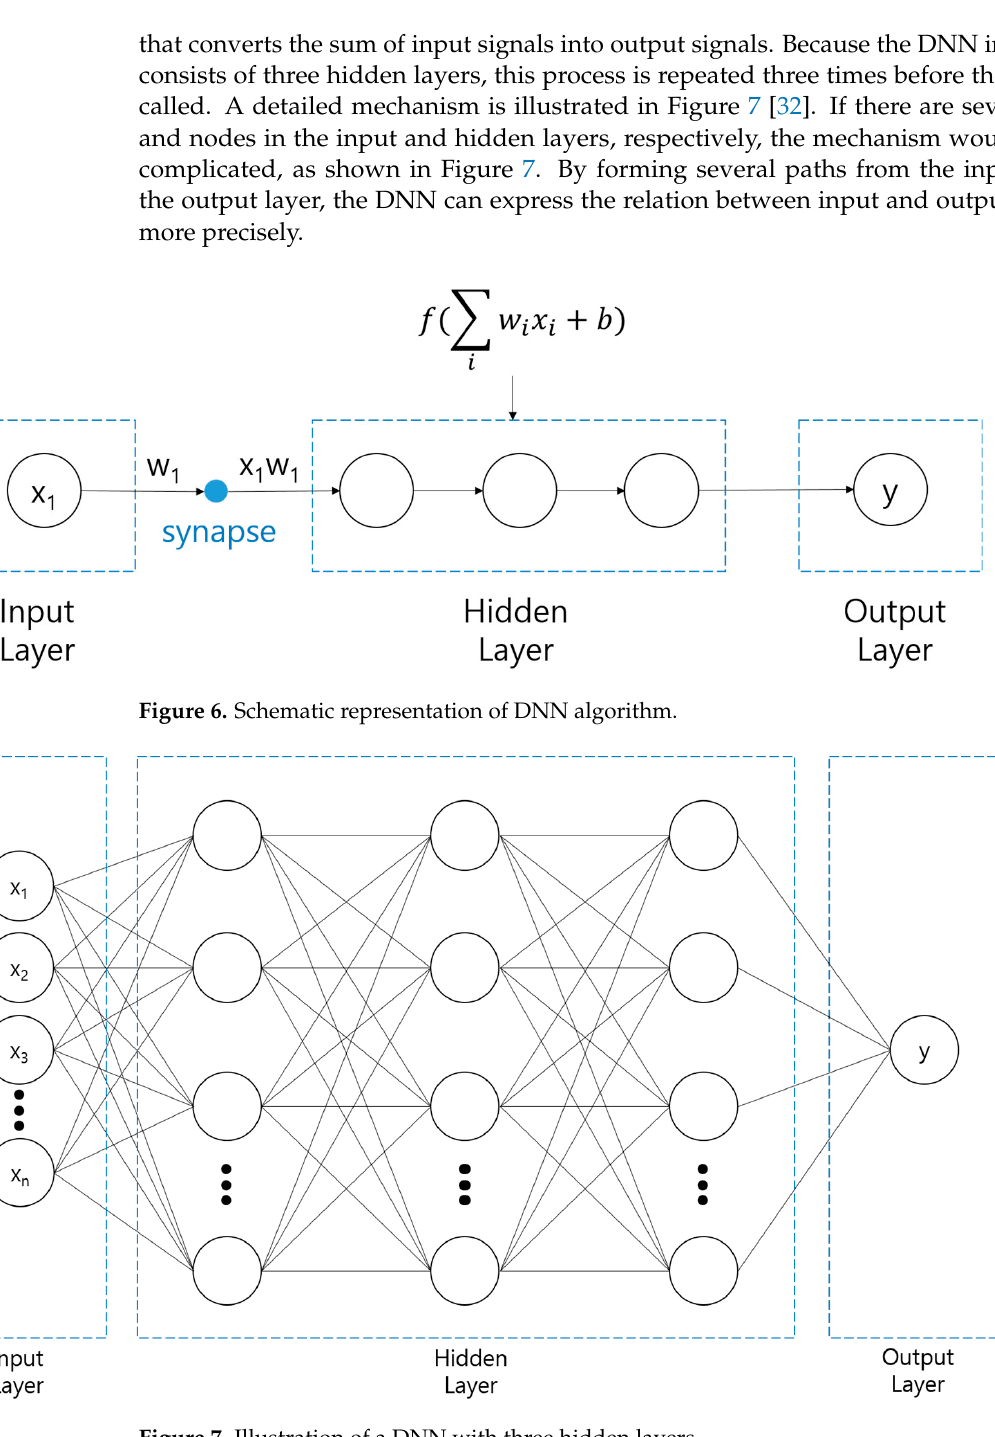
Figure 8. Graph of the ReLU function. 3.4. Random Forest The RF is an ensemble learning method that implements multiple DTs and optimally classifies data using the training data. Although the DT is effective for data classification, its performance varies significantly, and it contains different errors, mainly because the generated DT varies depending on the given training data. An RF algorithm was devel- oped to overcome this drawback. Figure 9 shows an RF algorithm that is made of multiple DTs, where each DT has slightly different characteristics owing to randomness. These characteristics improve the generalization performance of the algorithm. Meanwhile, when the data are trained to develop a prediction model using the RF algorithm, the stability, or accuracy of the model may be reduced owing to the trees. Hence, bagging is mainly used to sample the training data [35]. Bagging is an abbreviation for bootstrap aggregating, and it refers to the process of generating a dataset of the same size as the existing dataset by allowing duplicates in